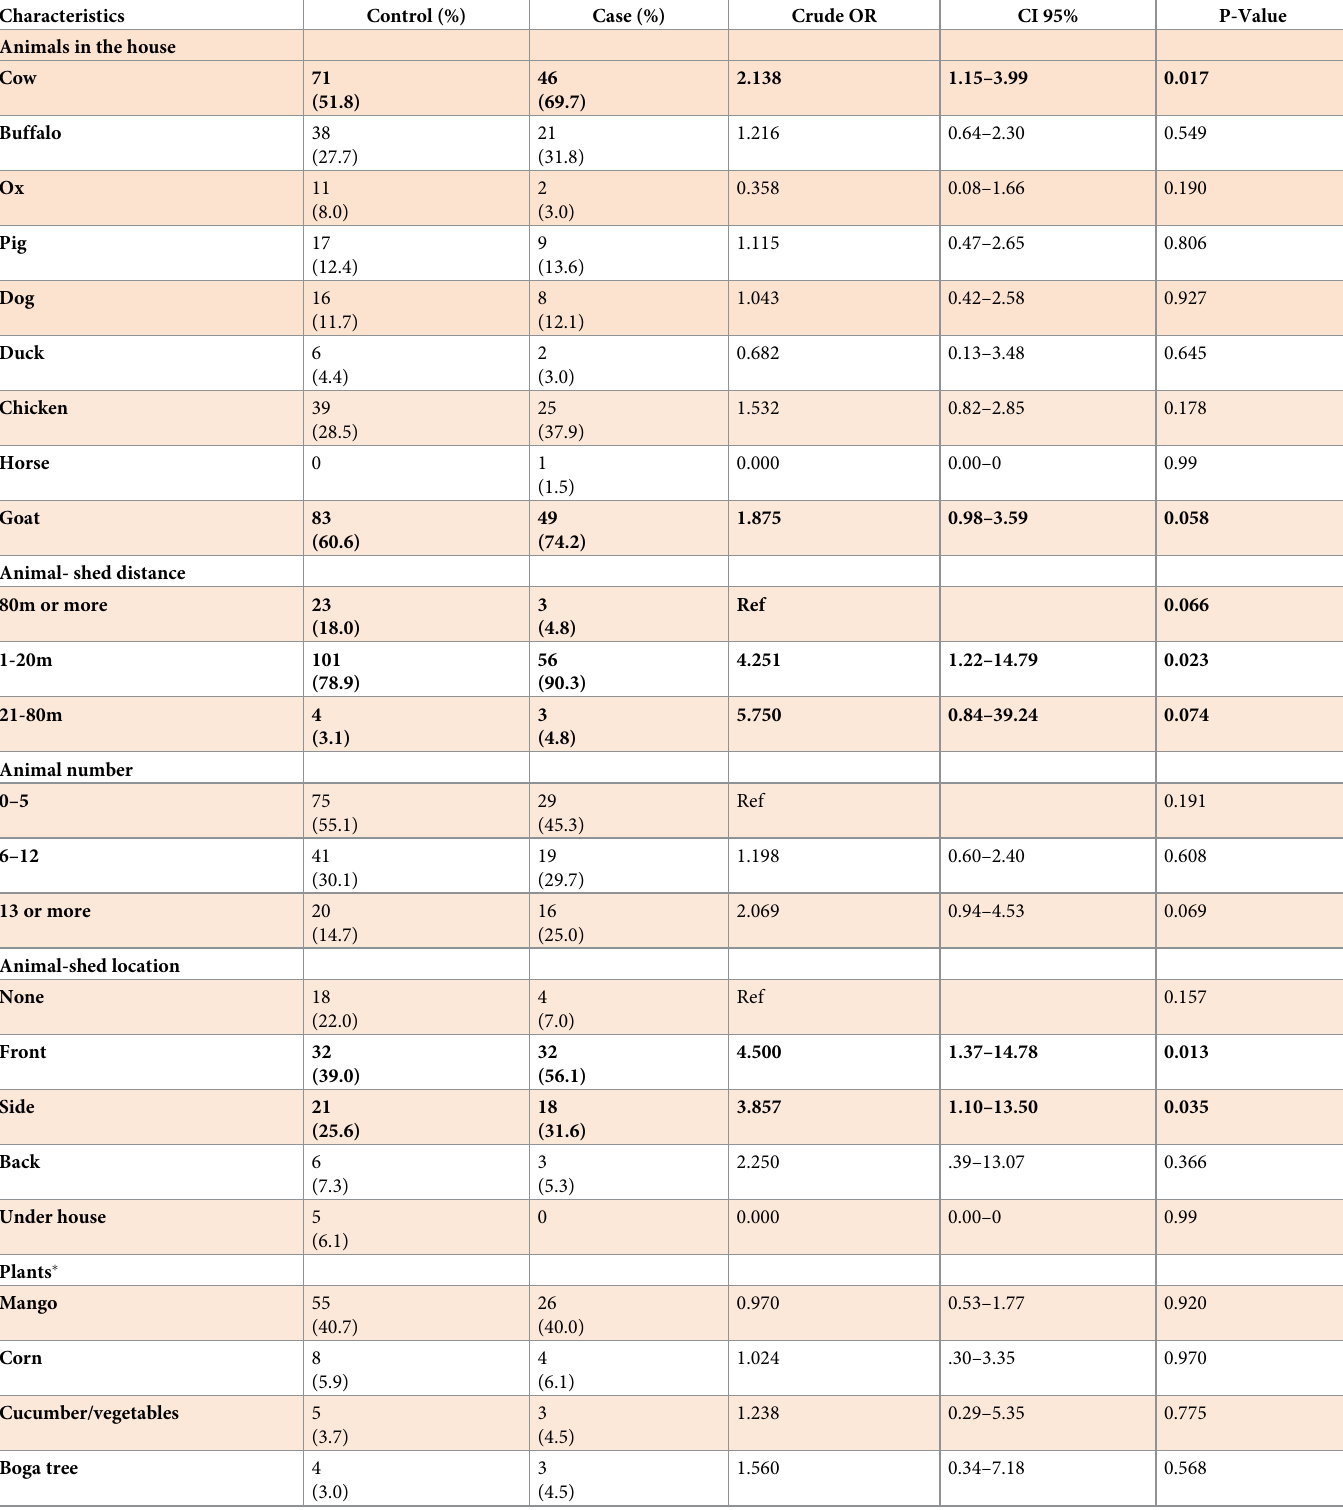
Table 2. Bivariate analysis of animals, animal shed, and plants around the house as VL risk factors.